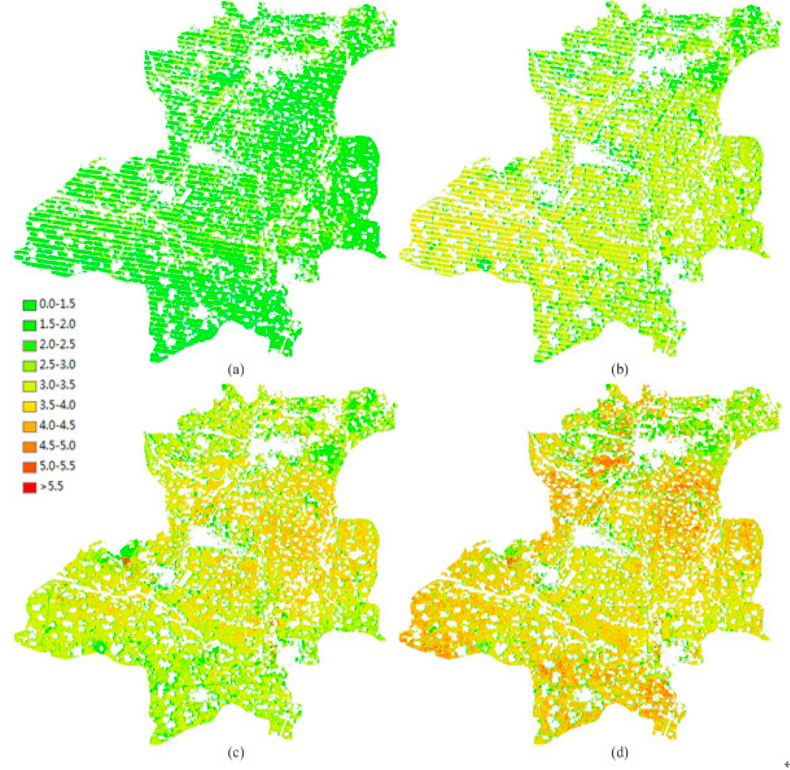
Figure 7. The LAI maps derived using the inferred leaf angle function from TLS scanner data on ( a ) 10 July (stem elongation stage), ( b ) 26 July (heading stage), ( c ) 19 August (flowering state), and ( d ) 4 September (grain-filling stage).